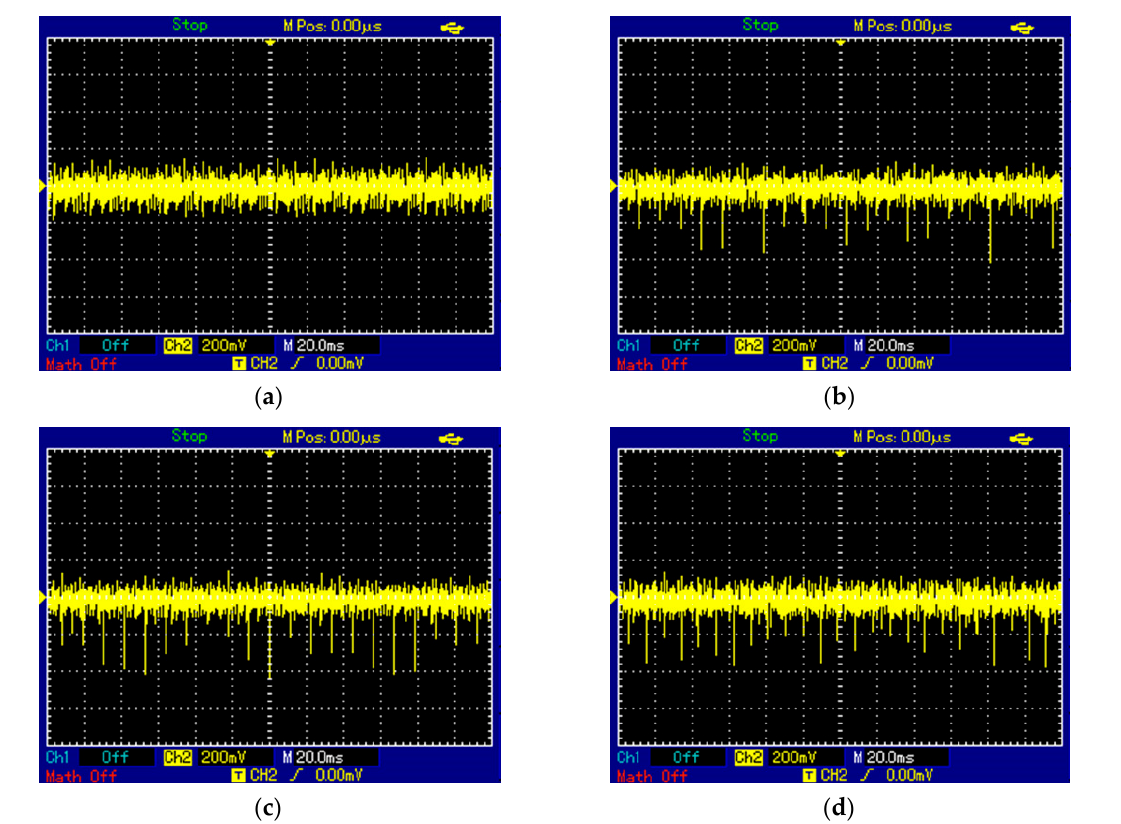
Figure 10. Oscillogram screenshots for different milk flow velocities: ( a ) 0 m/s; ( b ) 1.0 m/s; ( c ) 1.3 m/s; ( d ) 1.5 m/s.